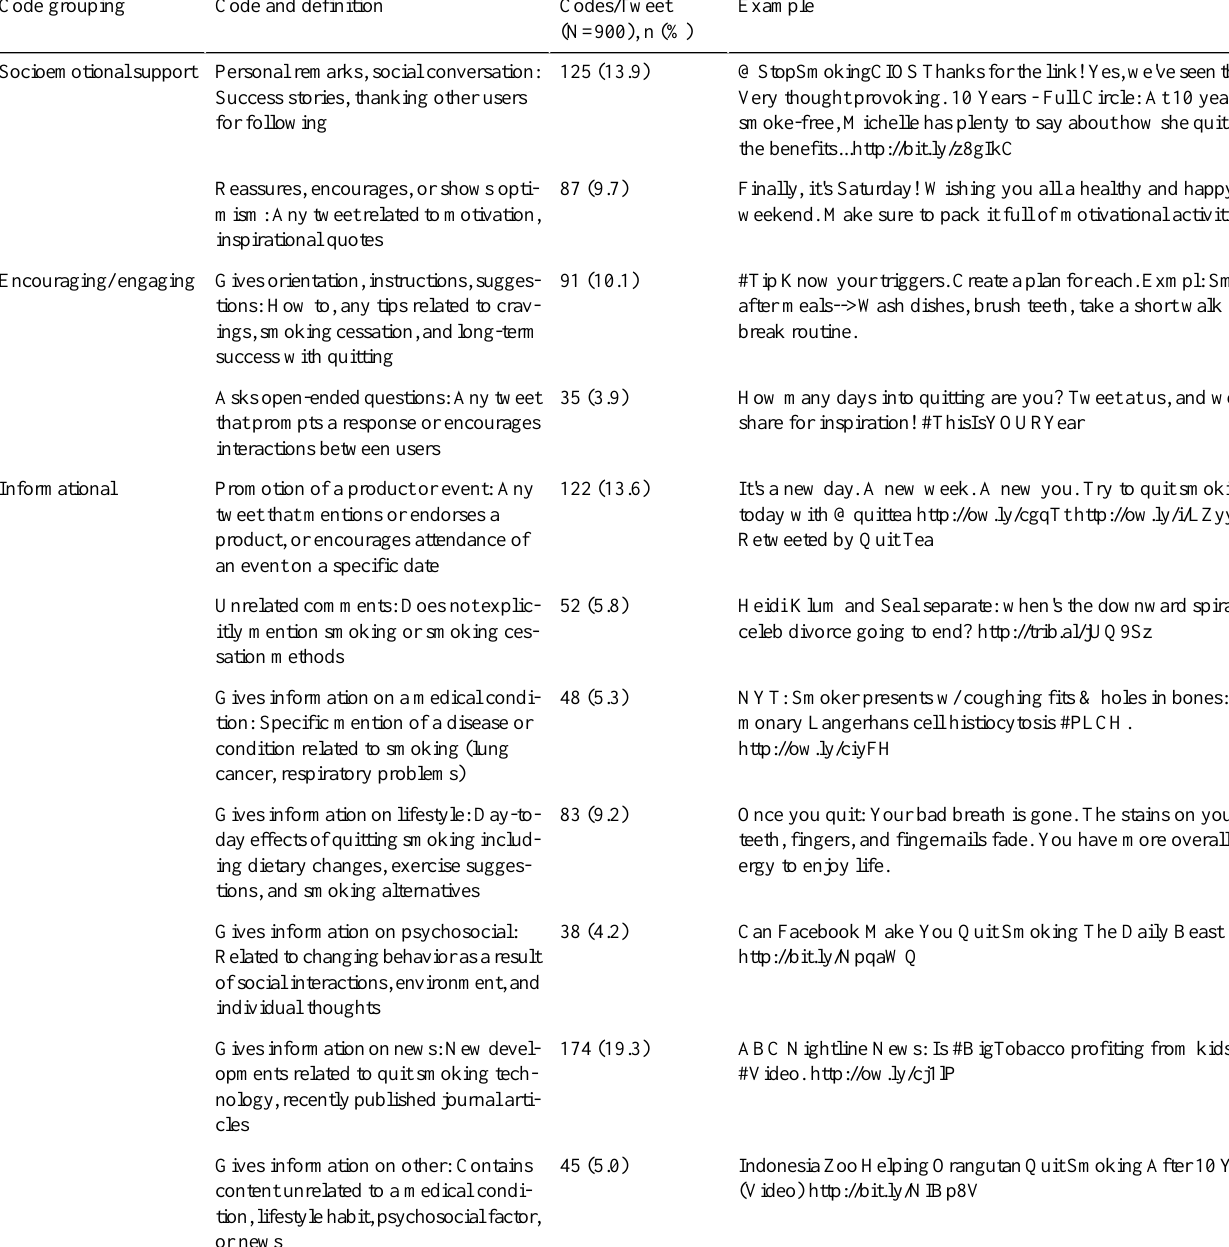
Table 2. Coding scheme of tweet content.